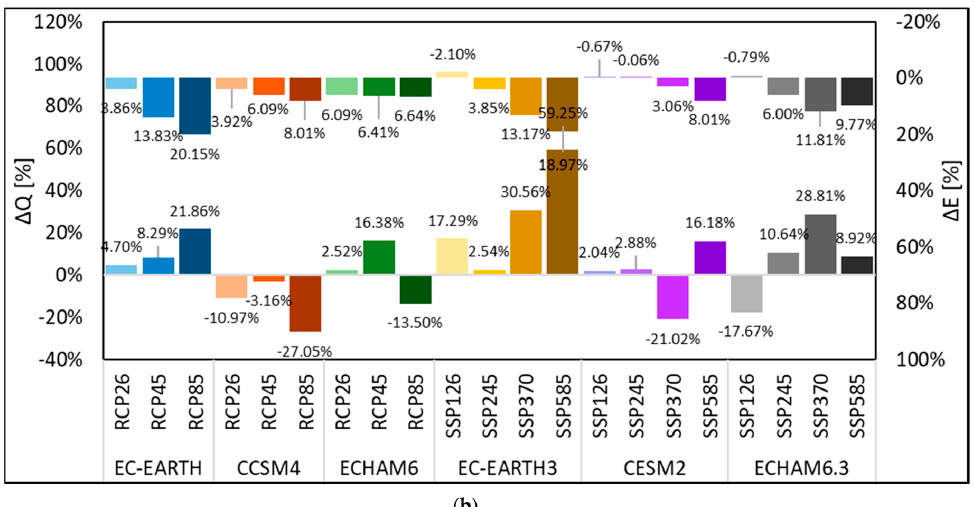
Figure 2. Mean projected annual variations of incoming discharge ∆ Q and energy production ∆ E with respect to the control run (CR) (2005–2015). In the x axis, we report the General Circulation Models (GCM), and the corresponding Representative Concentration Pathways (RCP) (for CMIP5), and Shared Socio-Economic Pathways (SSP) (for CMIP6). In the left y axis, we reported the projected annual (percentage) variation of the incoming discharge ∆ Q . In the right y axis, i.e., with the uppermost bars, with values to be read upside-down, we report the projected annual (percentage) variation of energy production, ∆ E . ( a ) Period P1. ( b ) Period P2.